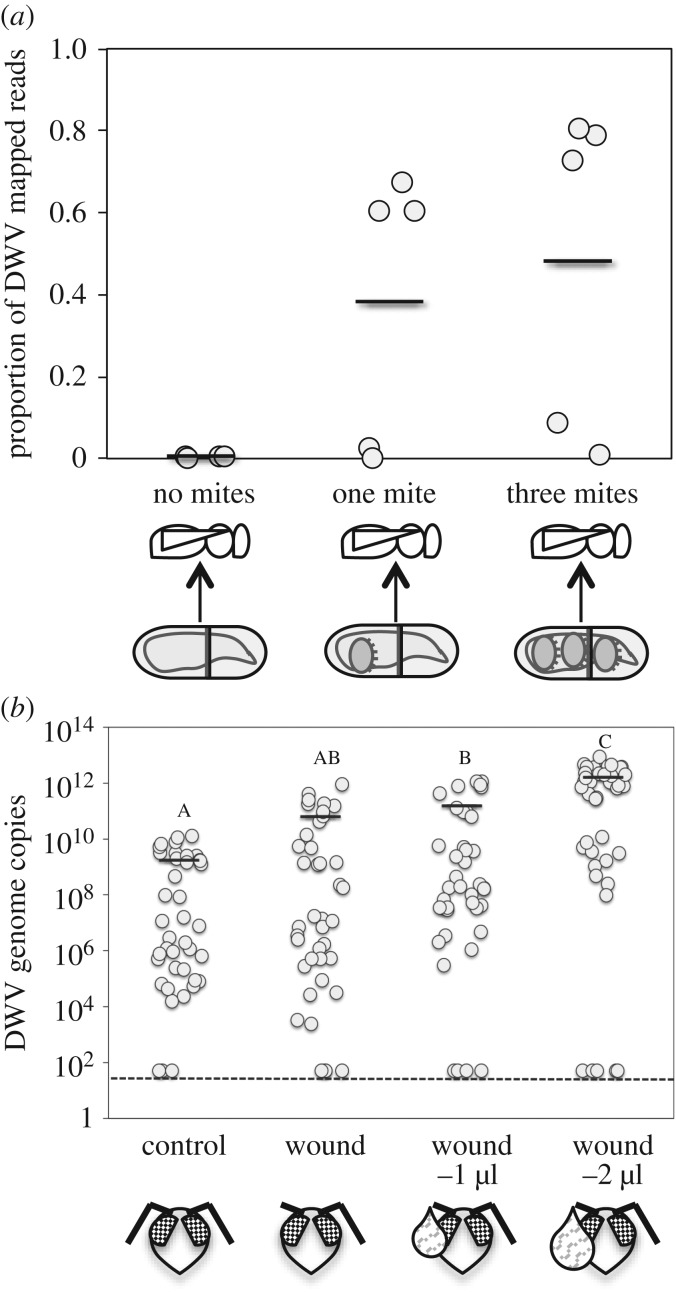
Increased feeding by Varroa mite as well as increased subtraction of haemolymph cause increased DWV infection in bees. (a) Viral load, as the proportion of reads mapping to DWV genome, in naturally infected bees artificially infested with no mites, one mite or three mites; the horizontal solid lines represent the average viral load. (b) The number of DWV genome copies in naturally infected bees after the removal of 1 or 2 µl of haemolymph through a wound is reported along the corresponding viral infection in control bees and wounded bees with no haemolymph subtraction. Different letters mark experimental groups significantly differing from each other (p < 0.001); consistently with the statistical analysis used here, the horizontal solid lines represent the average viral load.